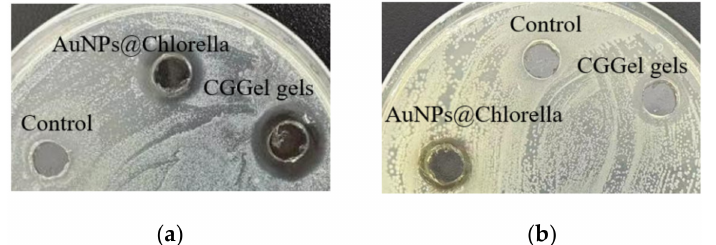
Figure 8. Photos showing E. coli ( a ) and S. aureus ( b ) zone of inhibition formation